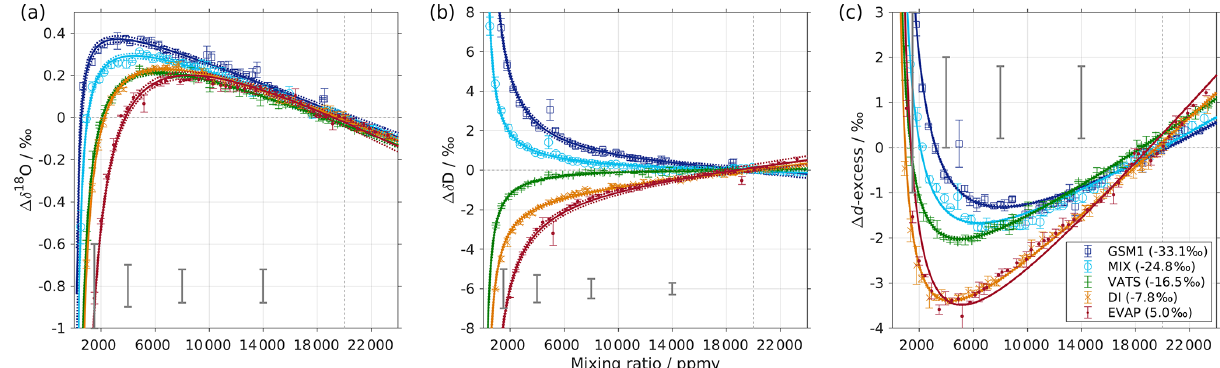
Figure 1. Mixing ratio dependency of uncalibrated measurements for (a) δ 18 O, (b) δ D, and (c) d -excess for five standard waters (GSM1, MIX, VATS, DI, and EVAP) on instrument HIDS2254 (Picarro L2130-i) with discrete liquid injections via an autosampler (experiment 1). Mixing ratio dependency is expressed as the deviation (cid:49) of the measured isotope composition at each mixing ratio with respect to the reference mixing ratio of 20000ppmv. The symbol and error bar represents the mean and the standard deviation of the mean for the last three of a total of four injections at each mixing ratio. Solid lines are fits with the function f (x) = a 95% confidence interval for the corresponding fit. Measurements and fits for d -excess are calculated with (cid:49)d -excess = (cid:49)δ D − 8 · (cid:49)δ 18 O. The typical 1 standard deviation of a single injection at the corresponding mixing ratio is indicated with grey error bars. Two outliers (at about 4300 and 8900ppmv) are removed from the GSM1 measurements, and one outlier (at about 9000ppmv) is removed from the VATS